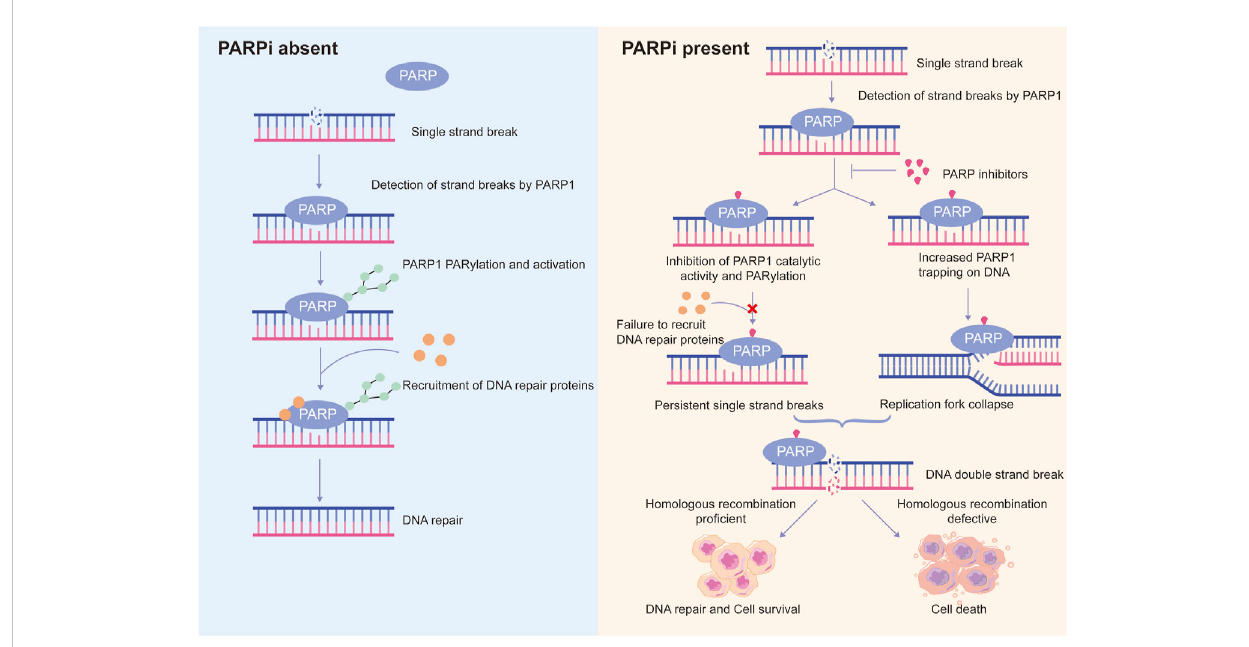
FIGURE 3 Schematic representation of the proposed mechanisms of action of PARP inhibitors. Normally, PARP1 detects DNA single strand breaks and is activated by them, leading to PARP1 auto-PARylation and recruitment of DNA repair proteins to trigger DNA repair. However, in the presence of PARP inhibitors (PARPi), on the one hand, PARPi suppresses PARP1 activity, recruitment of DNA repair proteins to damaged sites is inhibited, resulting in persistent single strand breaks; on the other hand, PARPi traps PARP1 at DNA lesions, the trapped PARP1-DNA complexes are cytotoxic and cause collapse of replication fork. Persistent single strand breaks and replication fork collapse will ultimately lead to DNA double strand breaks. In homologous recombination-pro fi cient cells, double strand breaks can be ef fi ciently repaired. In contrast, homologous recombination-defective cells are not able to repair double strand breaks ef fi ciently and accurately, leading to cell death. This is a phenomenon known as synthetic